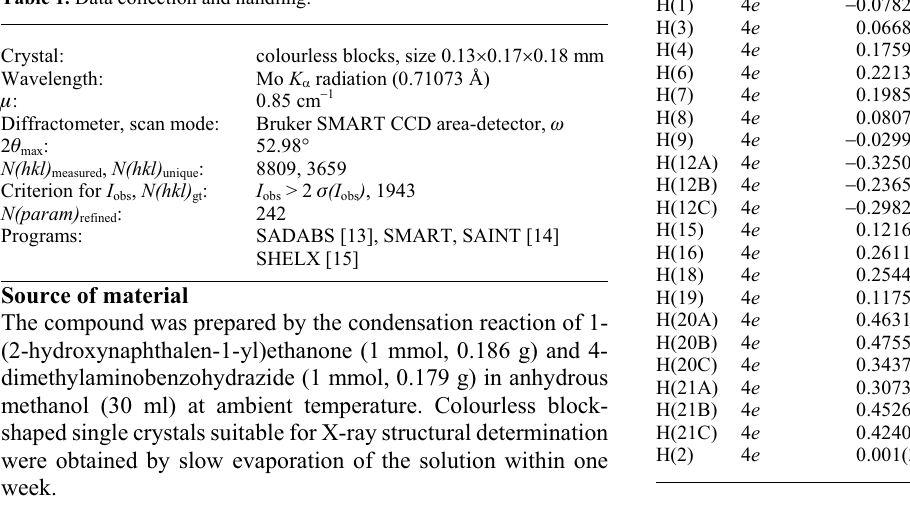
Table 1. Data collection and handling.